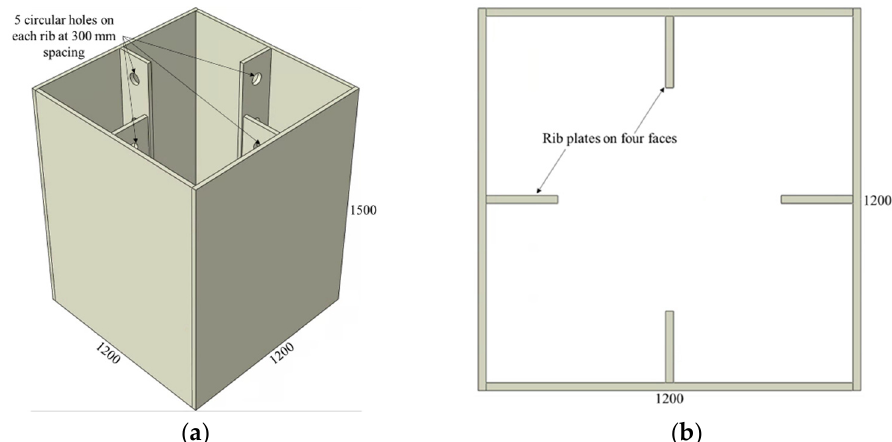
Figure 4. CFST column with rib plate connectors: ( a ) 3D view and ( b ) top view. Table 2. List of finite-element models with rib plate connectors.